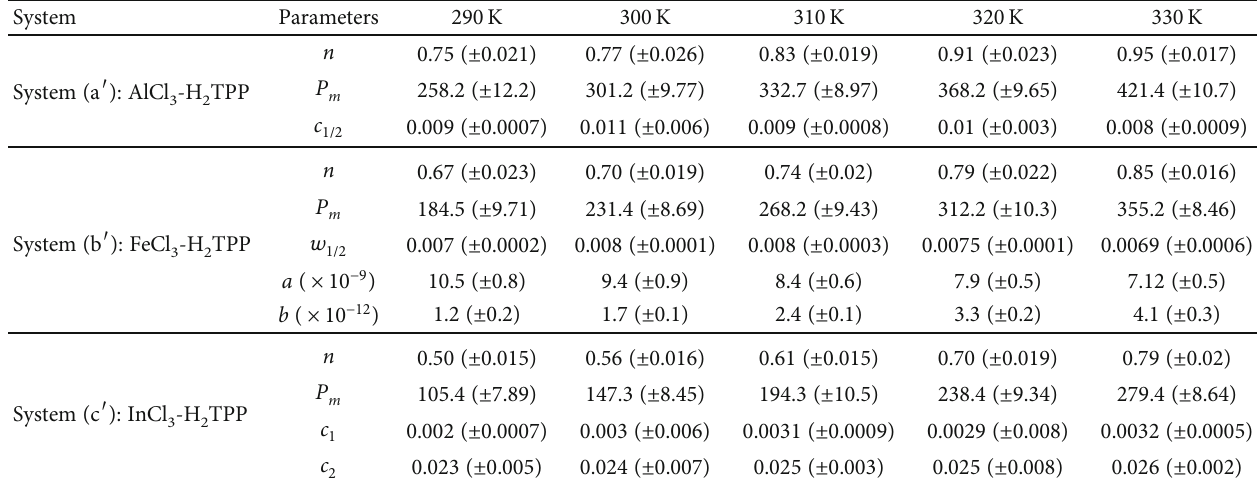
, a , b , c 1/2 , w 1/2 , c 1 , and c 2 ) deduced from the fi tting of experimental data of AlCl M